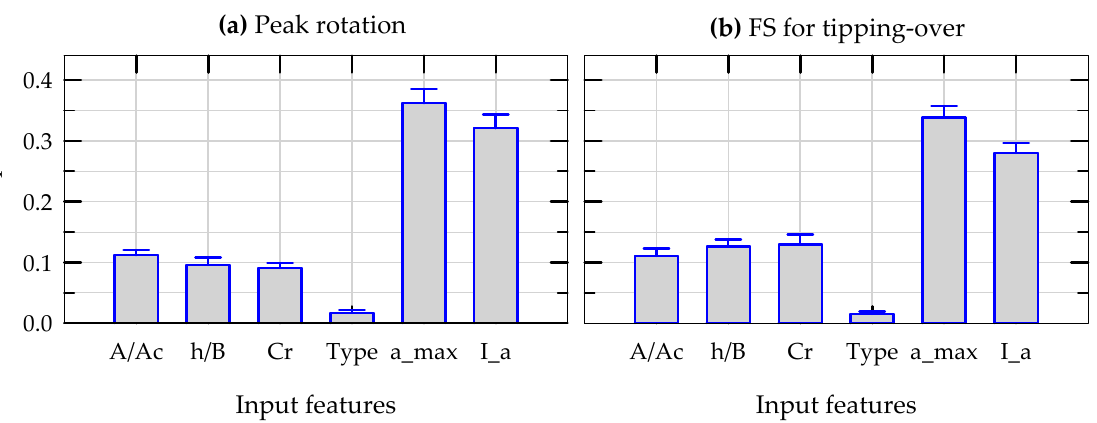
Figure 11. Results of mean (shown as boxes) and standard deviation (shown as error bars) of normalized feature importance scores for the prediction of ( a ) peak rotation and ( b ) factor safety for tipping over obtained from multiple RFR models.